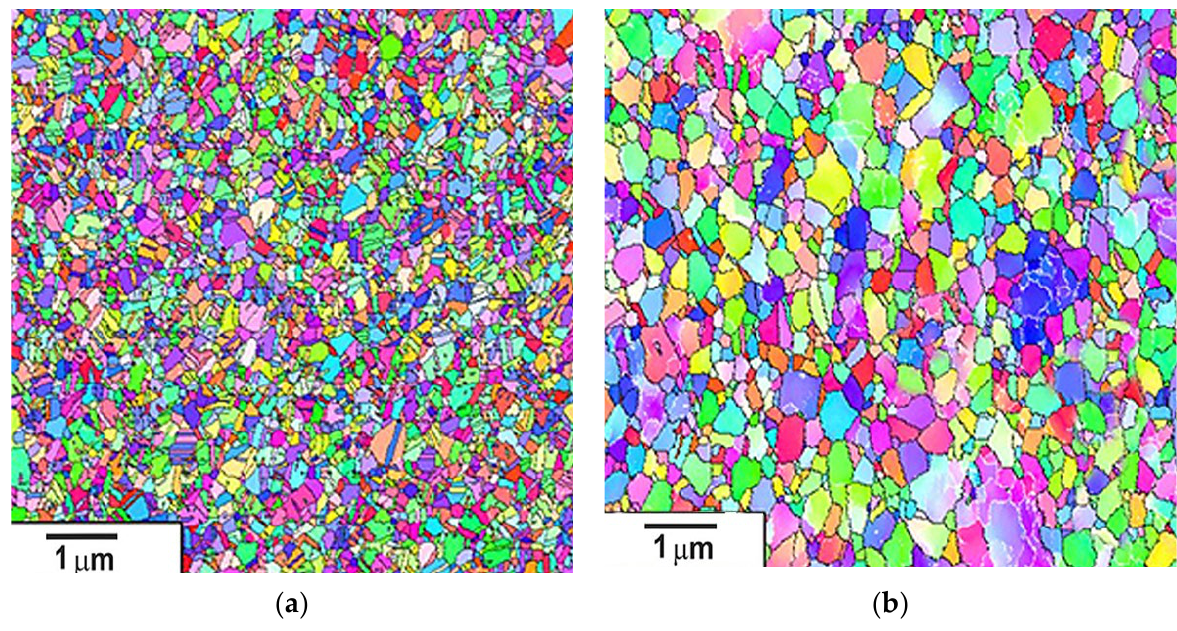
Figure 4. Microstructure orientation maps of AISI-304 steel after straining by HPT: ( a ) at cryogenic temperature; ( b ) at room temperature.